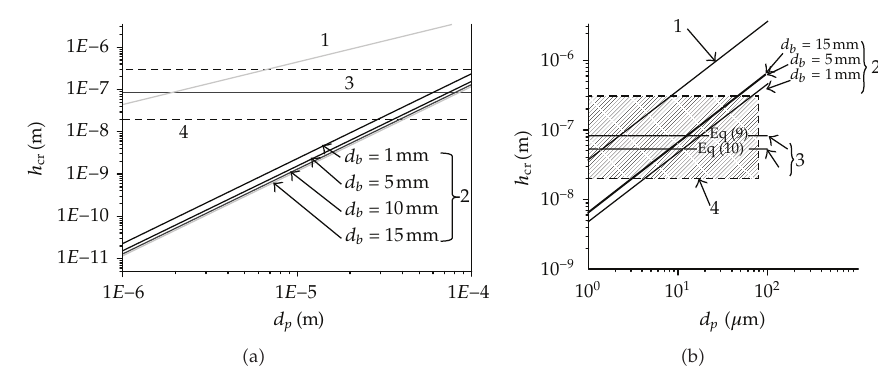
Figure 1: The critical film thickness (cid:4) h cr (cid:5) calculated as a function of the inclusion diameter (cid:4) d p (cid:5) , (cid:4) a (cid:5) alumina inclusion and (cid:4) b (cid:5) silica inclusion (cid:6) 13 (cid:7) .